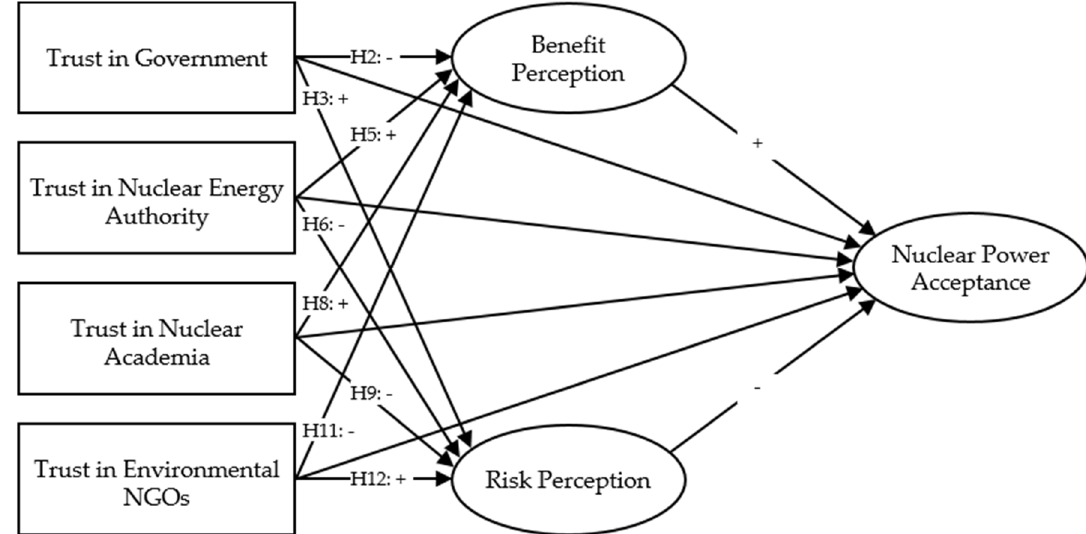
Figure 1. Our research model based on the trust–acceptability model. The total effect of each trust variable (H1, H4, H7 and H10) is not explicitly drawn here but we consider it. + : a positive effect hypothesized; - : a negative effect hypothe- sized.